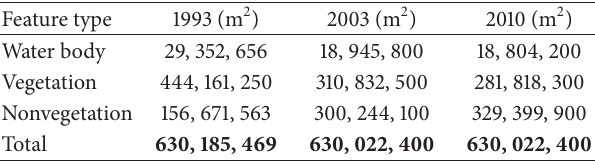
Table 2: The statistics of LULC changes in 1993, 2003, and